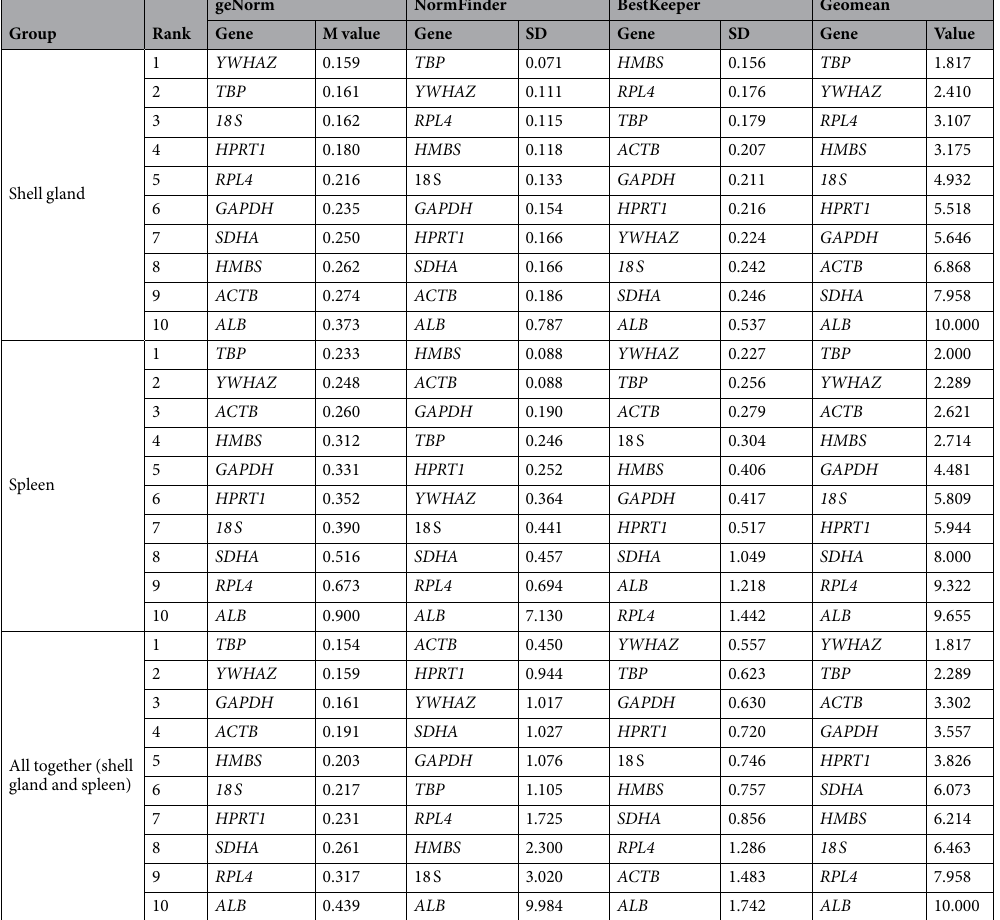
Table 1. Overall stability values of reference genes in the combined data set of shell gland and spleen affected by IBV T and Vic S strain challenge. The Cq values were analysed in geNorm, NormFinder and BestKeeper and a comprehensive ranking (geomean) was calculated by assigning an appropriate weightage to individual gene ranking obtained in individual software. A total of 10 samples for each of the groups (IBV T, Vic S and control) in each tissue (shell gland or spleen) were processed for qPCR